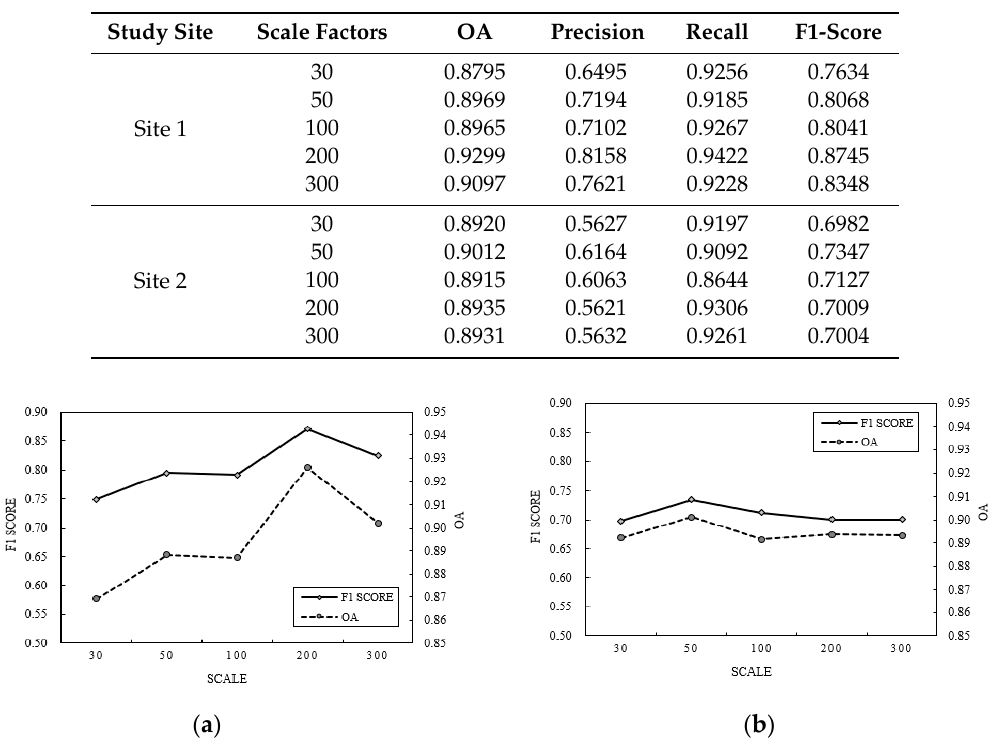
Table 6. Accuracy of CD maps generated using the proposed methods with di ff erent scale factors.